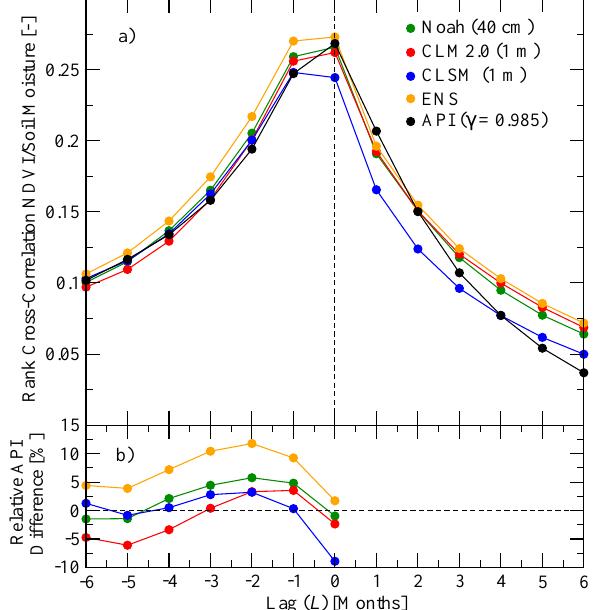
Fig. 5. Quasi-global land averages of (a) R(L) for Noah, CLM2.0, CLSM, ENS, and API root-zone soil moisture predictions, and (b) percentage relative R(L) difference for the modern LSMs (Noah, CLM2.0, CLSM, and ENS) versus an API baseline (i.e., 100 ·[ R(L) LSM − R(L) API ] /R(L) API